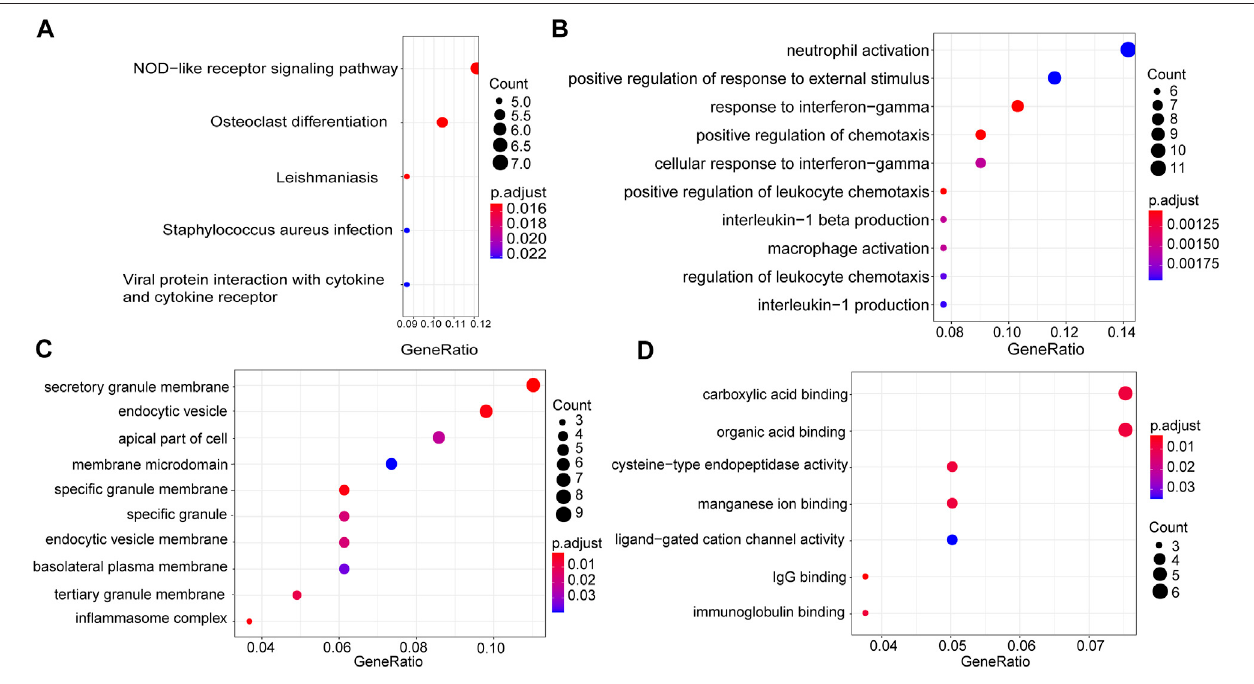
FIGURE4| Pathwayandfunctionalenrichmentanalysisofgenesinthethistle1module. (A) KEGGpathwayanalysis. (B) GOenrichmentforbiologicalprocess. (C) GO enrichment for cellular composition. (D) GO enrichment for molecular function. The x -axes are the ratio of genes, and the y -axes are the GO terms.